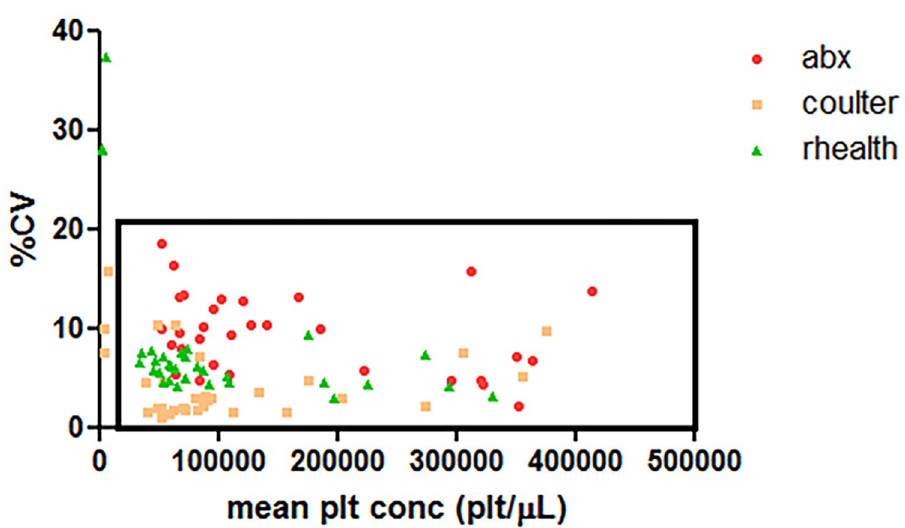
Fig 5. Graphical analysis of the ABX, Coulter ISLH, and rHEALTH precision data. The effect on platelet counts precision (N = 16 per condition). The precision for ABX Micros 60 at 2.2–18.7%, Coulter ISLH at 1.0–15.9 and the rHEALTH at 3.1–37.5% for all samples. Excluding the anti-platelet antibodies, which yielded close to zero counts via Coulter ISLH and the rHEALTH, the precision for non-zero platelet counts, indicated in the boxed area,was as follows: ABX Micros 60 at 4.5–18.7%, Coulter ISLH at 1.0–10.5 and the rHEALTH at 3.1–8.0%. can leverage the technology’s good correlation between capillary and venous blood samples for sound clinical decision-making related to normal and thrombocytopenic blood samples.